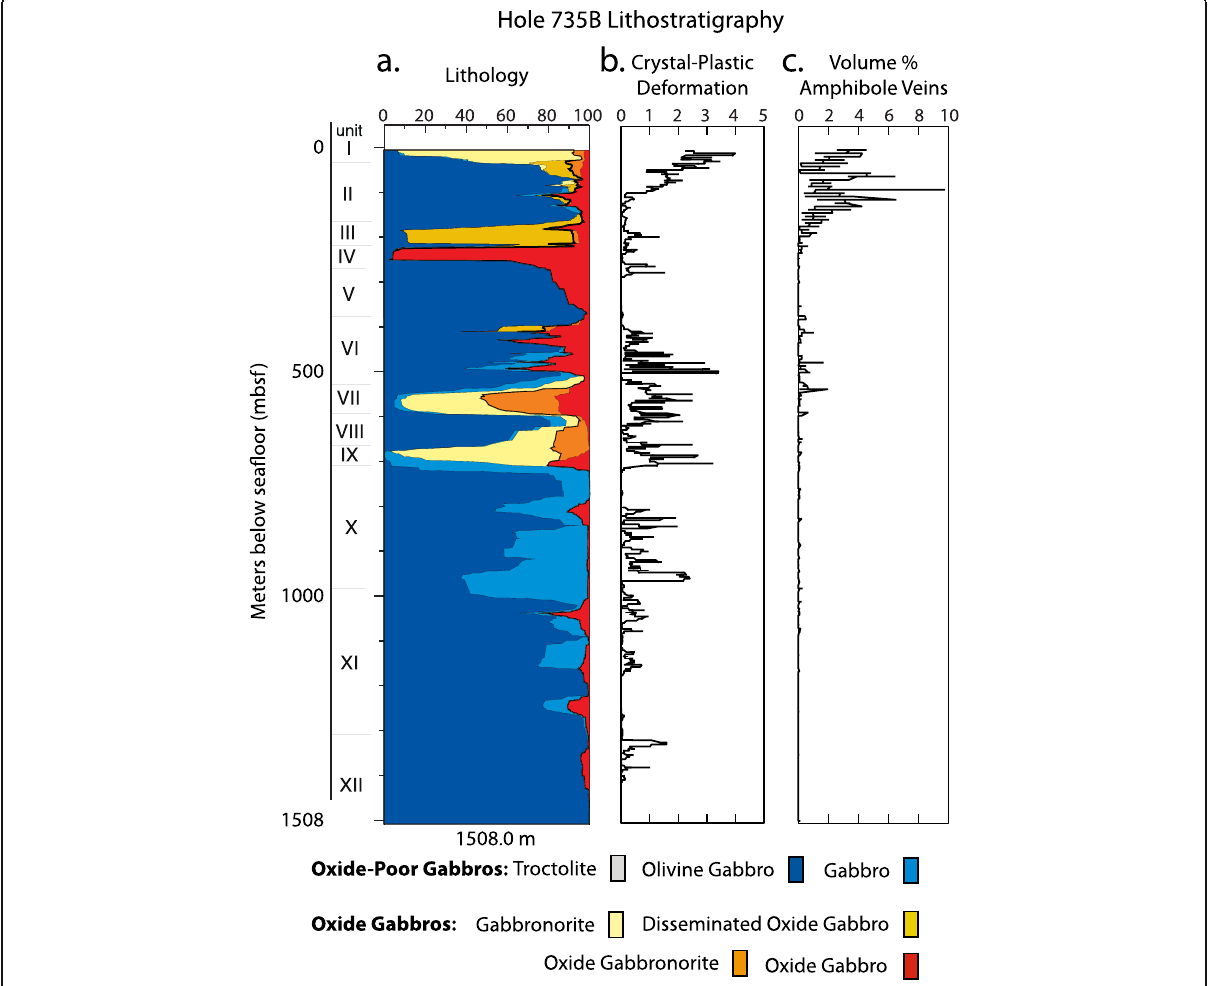
Fig. 40 Hole 735B lithostratigraphic variations: a Relative abundances of igneous rocks averaged over a moving downhole running average of 20 igneous intervals. A total of 952 discrete igneous intervals were described and are included in the running average. Rock names follow the standard IUGS classification with modifiers to indicate oxide abundance. b Crystal-plastic deformation intensity from zero (undeformed) to five (ultramylonite). c Amphibole veins by core percentage averaged over a 2 m window. Modified from Dick et al.